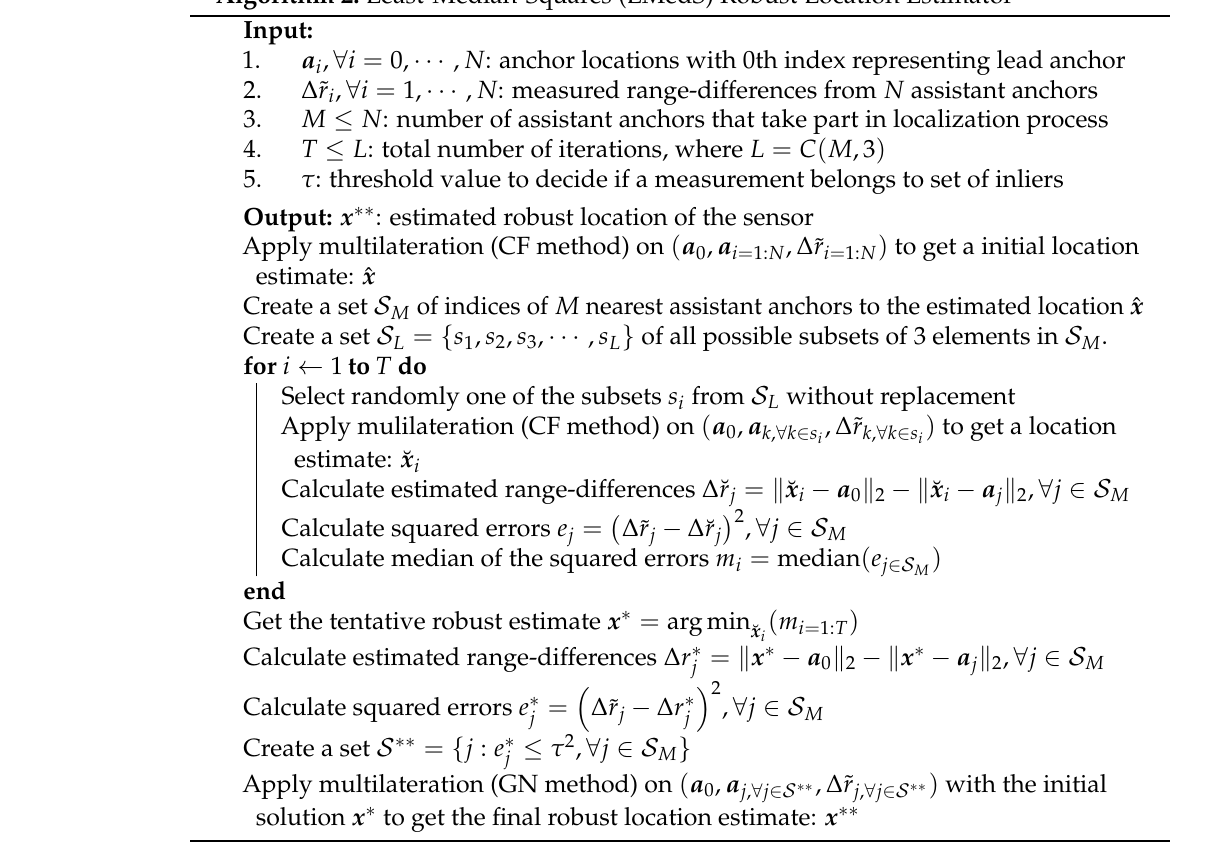
Algorithm 2: Least-Median-Squares (LMedS) Robust Location